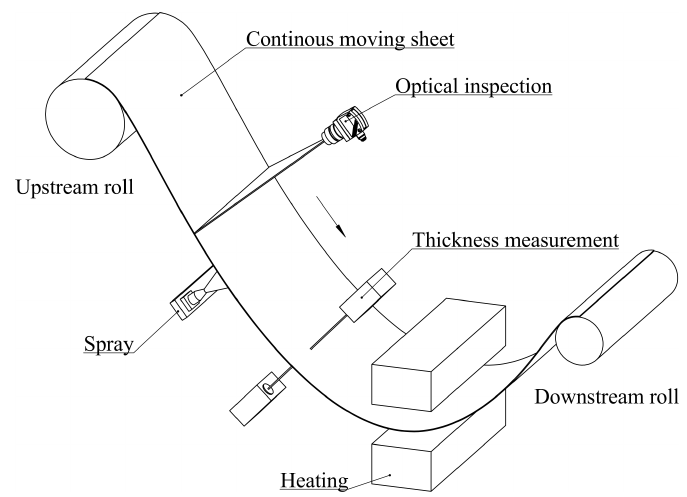
Figure 1. Non-contact measurement or processing around continuous moving thin-sheet materials hanging between